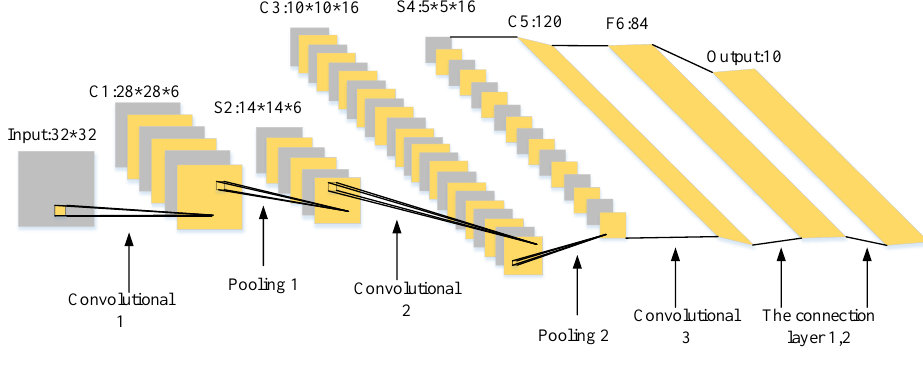
Figure 1. Architecture of LeNet.